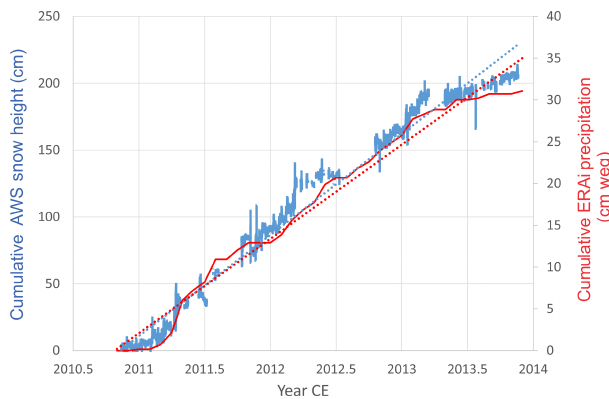
Figure 3. Comparison of snow accumulation data recorded by the RICE AWS (blue) in cumulative snow height in centimetres and ERAi precipitation values (red) in centimetres water-equivalent cu- mulative height for the RICE drill location. Dotted blue and red lines indicate linear trends for AWS and ERAi data,